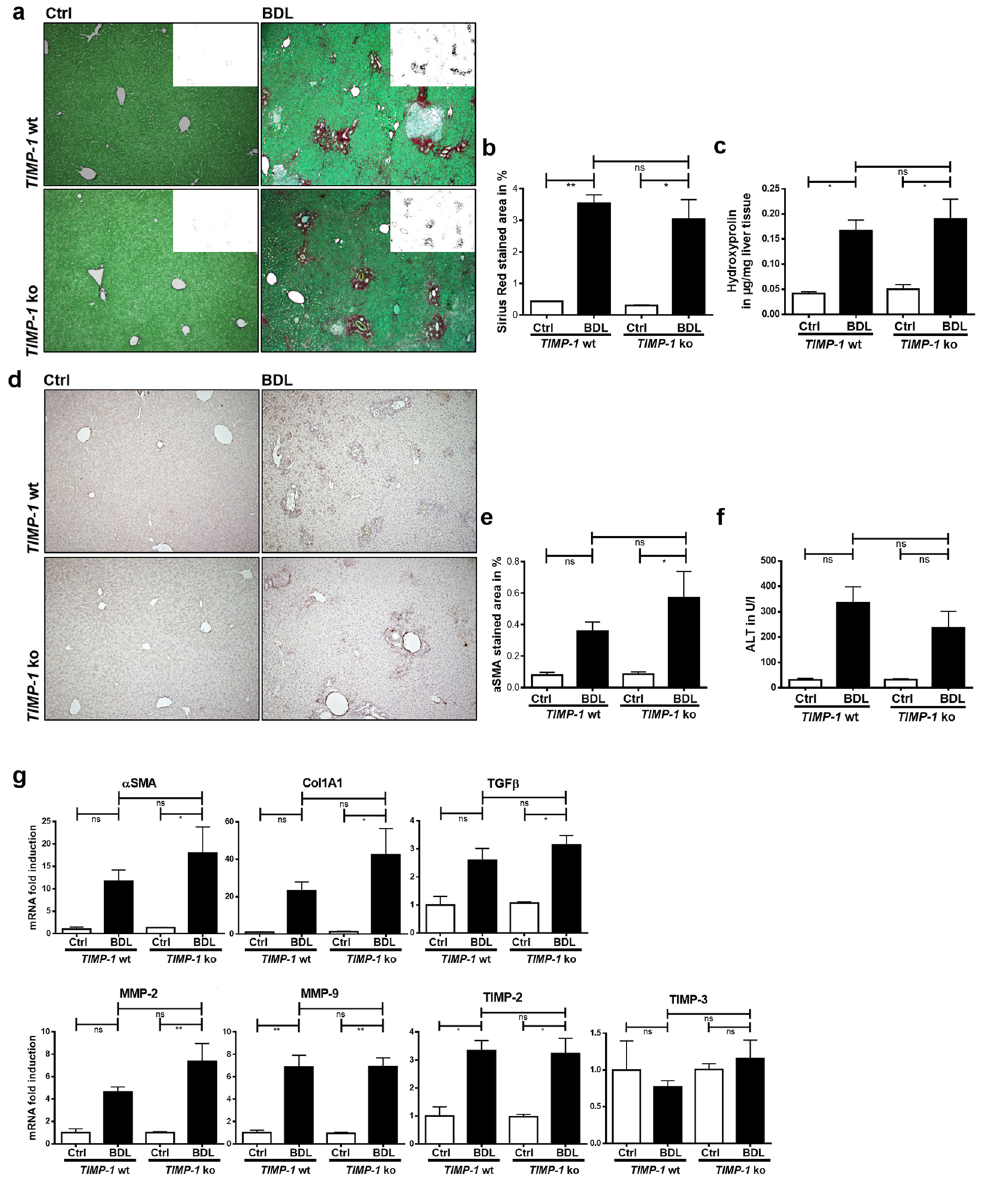
Figure 2. TIMP-1 deficiency does not prevent hepatic fibrogenesis in the BDL model. ( a ) Collagen content of livers 21d post BDL was assessed by Sirius Red staining. TIMP-1 deficiency does not alter Collagen content compared to TIMP-1 wt, as shown in representative images and in ( b ) quantification of Sirius Red positive stained area. ( c ) Hepatic hydroxyproline content shows also an induction after BDL treatment, but no differences between TIMP-1 ko and wt. ( d , e ) α SMA IHC indicates hepatic stellate cell activation and was increased in livers following 21d of BDL. TIMP-1 ko have the same amount of α SMA positive cells compared to TIMP-1 wt. ( f ) Liver transaminases (ALT) were elevated following BDL but did not differ significantly between TIMP-1 wt and TIMP-1 ko . ( g ) Fibrosis-related genes were upregulated in BDL livers, but no differences could be observed between TIMP-1 wt and TIMP-1 ko mice. Bar columns represent mean ± standard error of the mean. ** p < 0.01; * p < 0.05; ns (non-significant). (Untreated controls n = 2–4, BDL n =